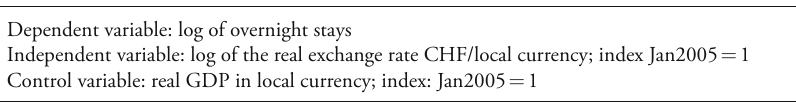
Table 1: Overall